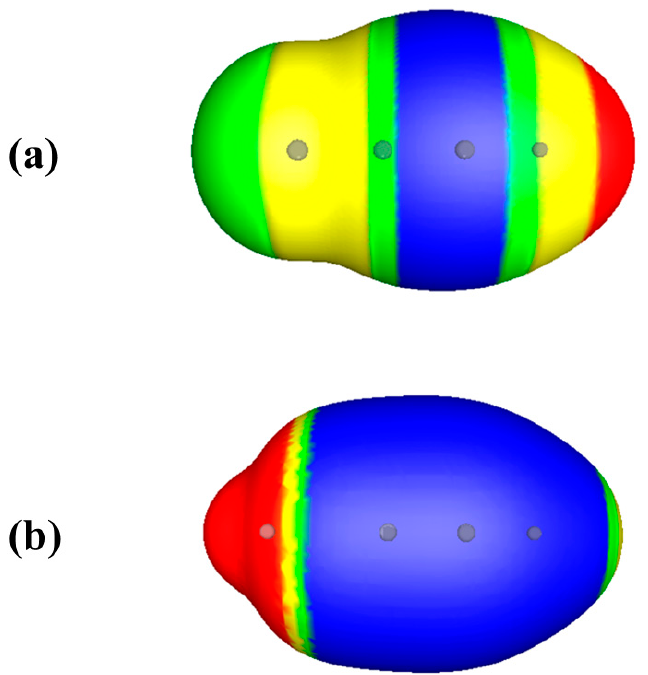
Figure 3. Computed electrostatic potentials on 0.001 au surfaces of ( a ) fluoroacetylene, FC ≡ CH, and ( b ) lithium acetylene, LiC ≡ CH. Circles indicate positions of nuclei. Fluorine is at the left in ( a ), lithium is at the left in ( b ). Color ranges, in kcal/mol, are—red, more positive than 15; yellow, between 15 and zero; green, between zero and − 5; blue, more negative than − 5.